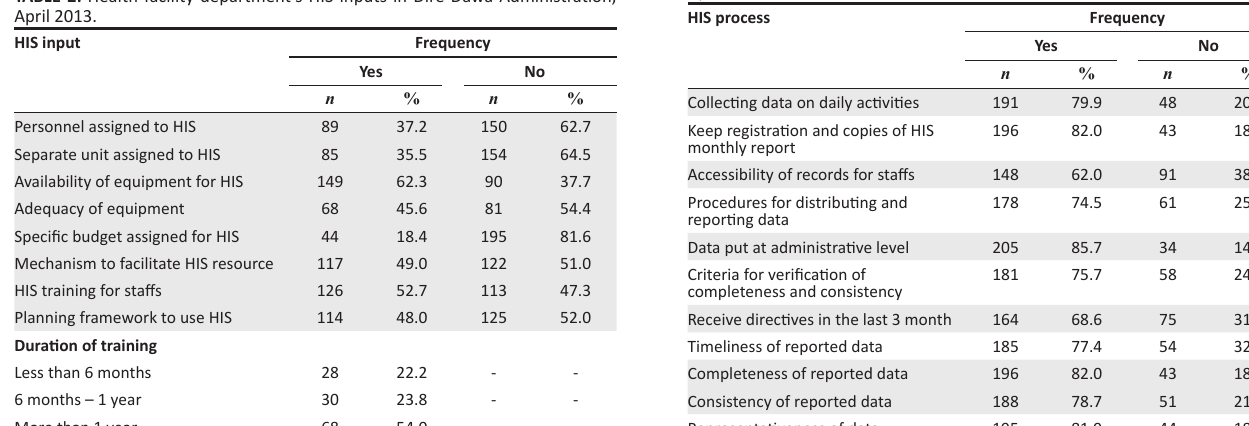
TABLE 3: Health facility department’s HIS process in Dire Dawa Administration, April